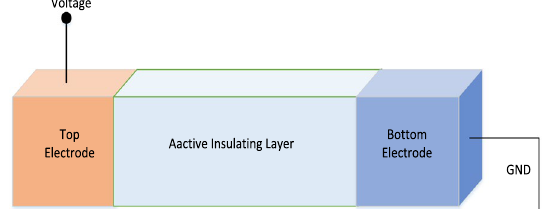
Fig. 3 Schematic of metal–insulator–metal structure for